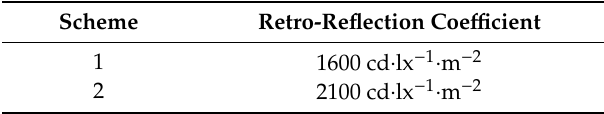
Table 6. Retro-reflection coefficient under different schemes.